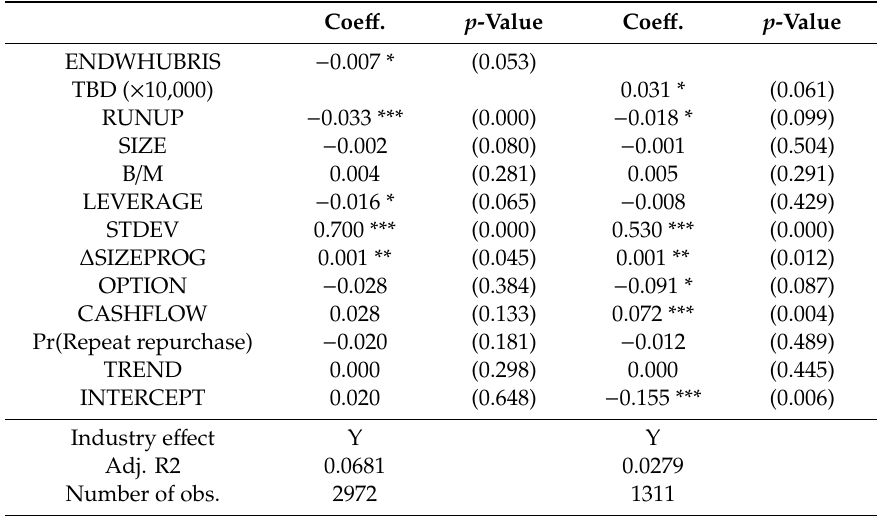
Table 8. Regressions of repeat repurchasers’ abnormal returns with time trend. Coe ff . p -Value Coe ff . p